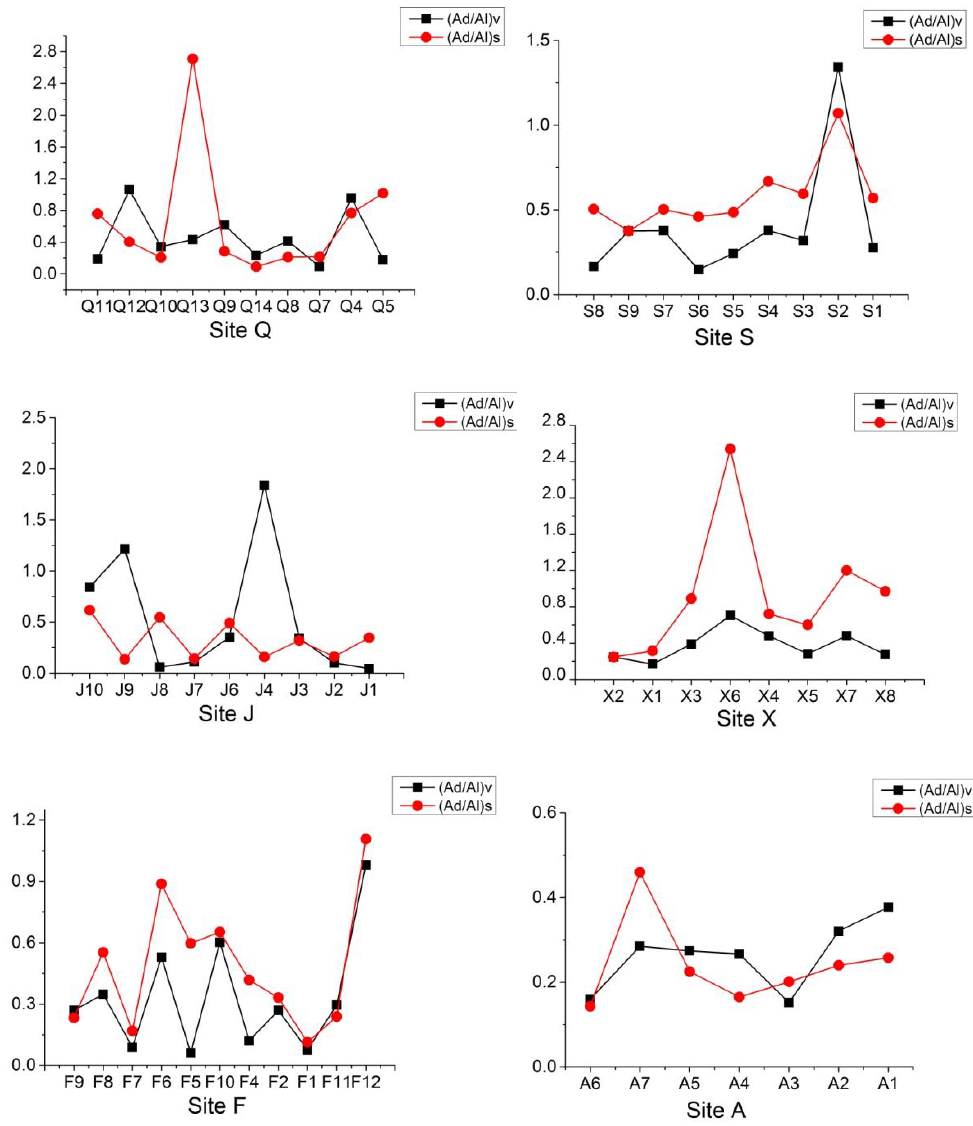
Figure 5. Spatial distribution of ( a ) Λ, ( b ) TOC, TN, ( c ) TOC/TN molar ratio, ( d ) (Ad/Al)v and (Ad/Al)s ratios.